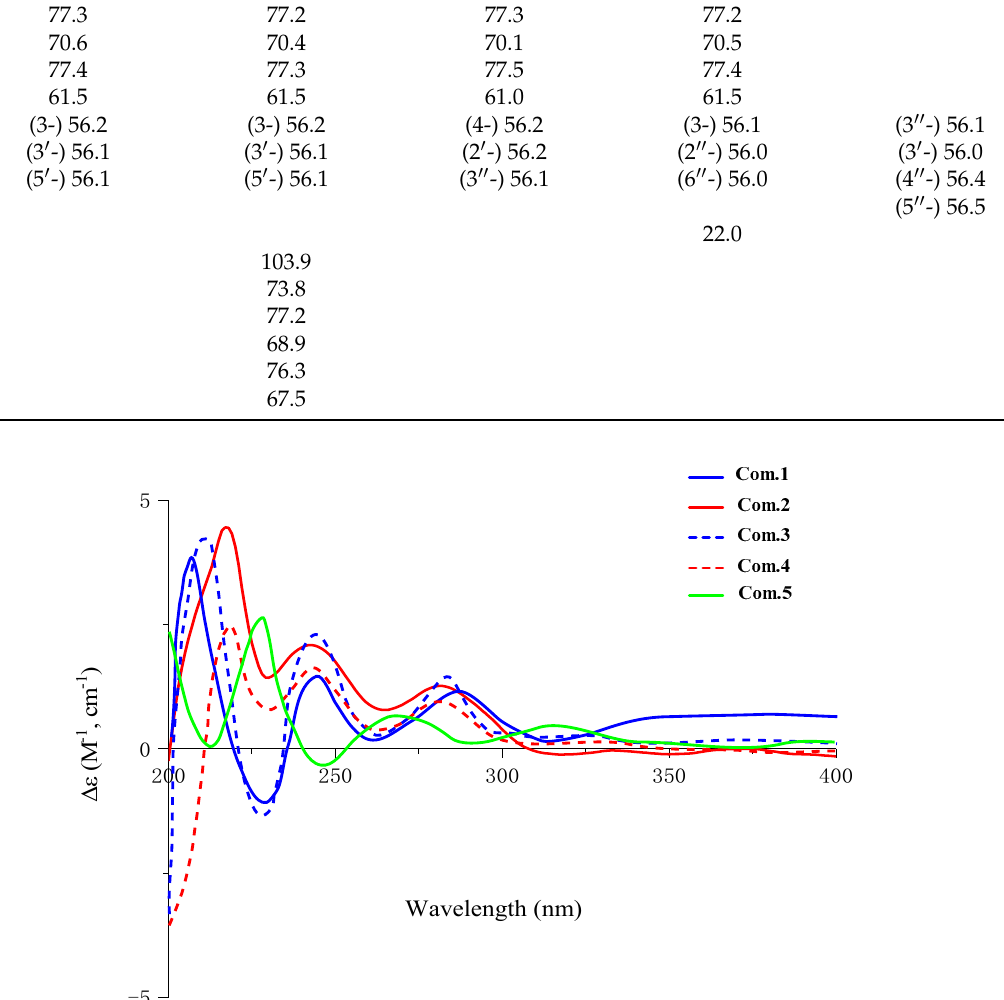
Figure 2. The CD spectra of compounds 1 – 5 (MeOH). Compound 2 was obtained as a white amorphous powder, and its molecular for- mula was confirmed asC 42 H 54 O 21 , determined by HRESIMS 895.8730 [M + H] + (calcd. for C 42 H 55 O 21 895.8730). Careful comparison of the NMR data of 2 (Tables 1 and 2) with those